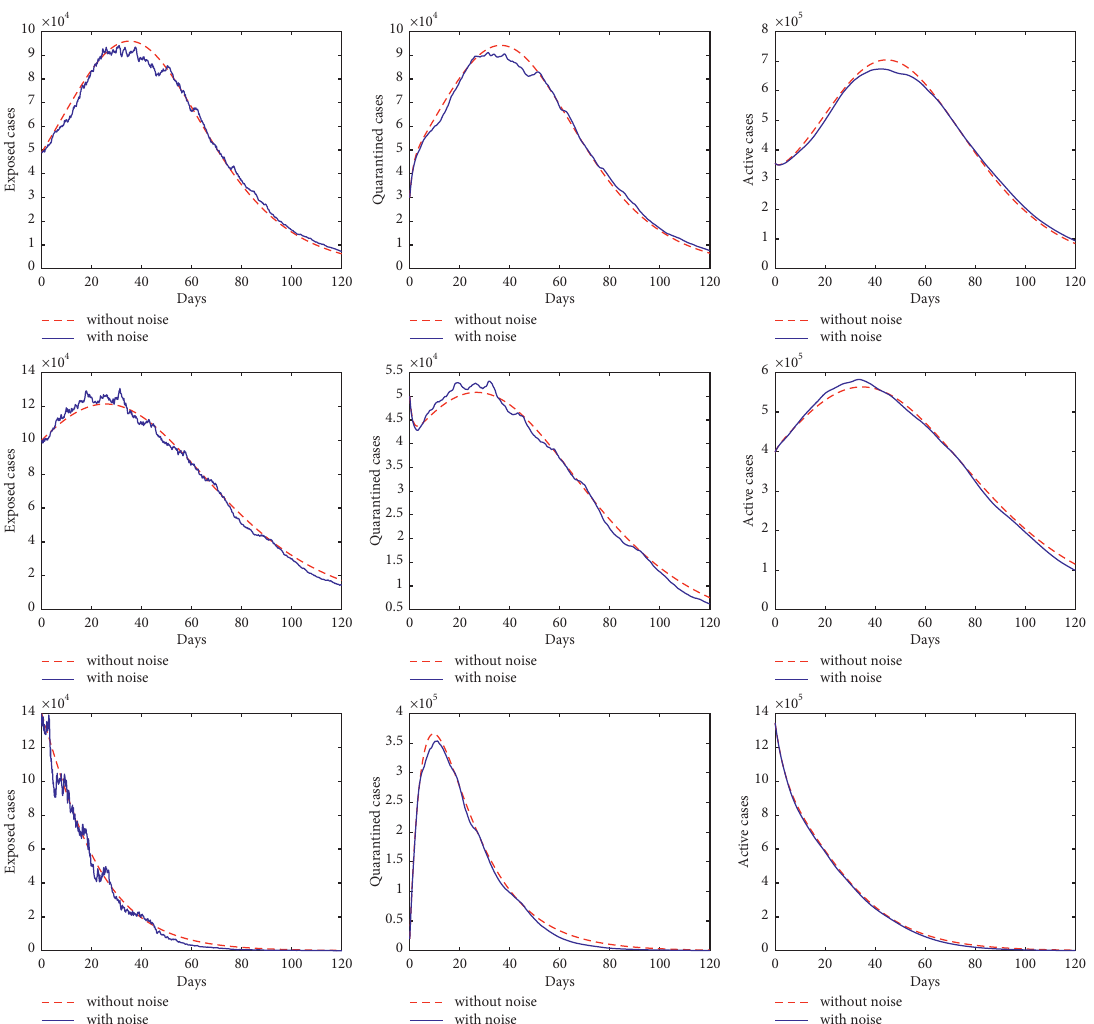
Figure 5: The solutions of system (2) with σ � 0 . 02. The first row is the case of France, the middle row is the case of Italy, and the last row is the case of the UK. All parameters are listed in Table 1.